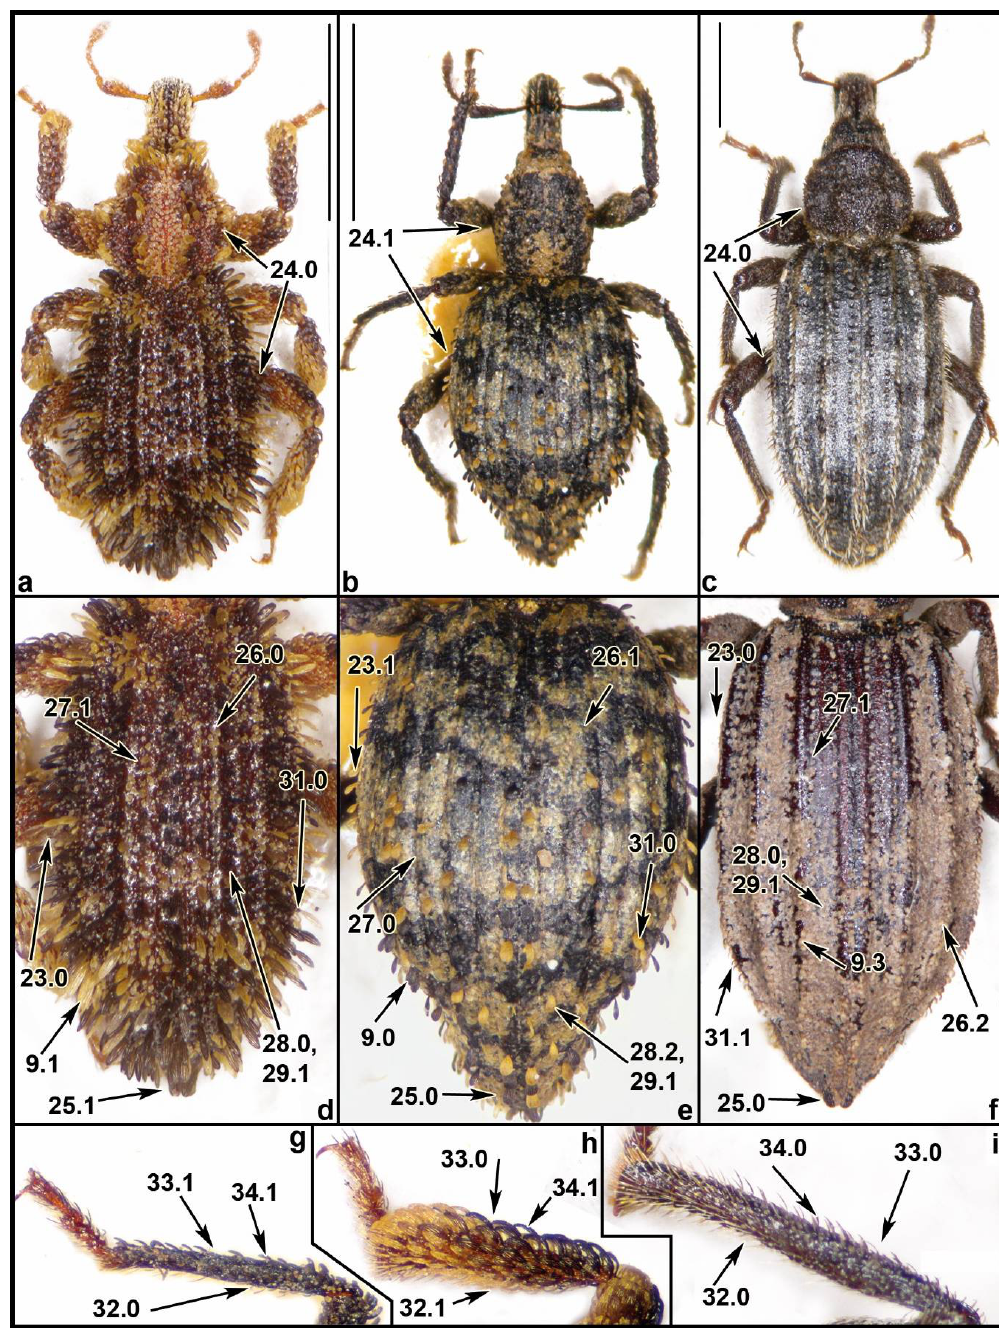
Figure 1. Body of Dichotrachelus baldensis Barajon ( a ); D. afer Peyerimhoff ( b ); D. manueli Marseul ( c ). Elytra of D. baldensis ( d ); D. afer ( e ); D. linderi (Fairmaire) ( f ). Protibia of D. afer ( g ); D. baldensis ( h ); D. manueli ( i ). Not in scale. Bars for body size. 2 mm.